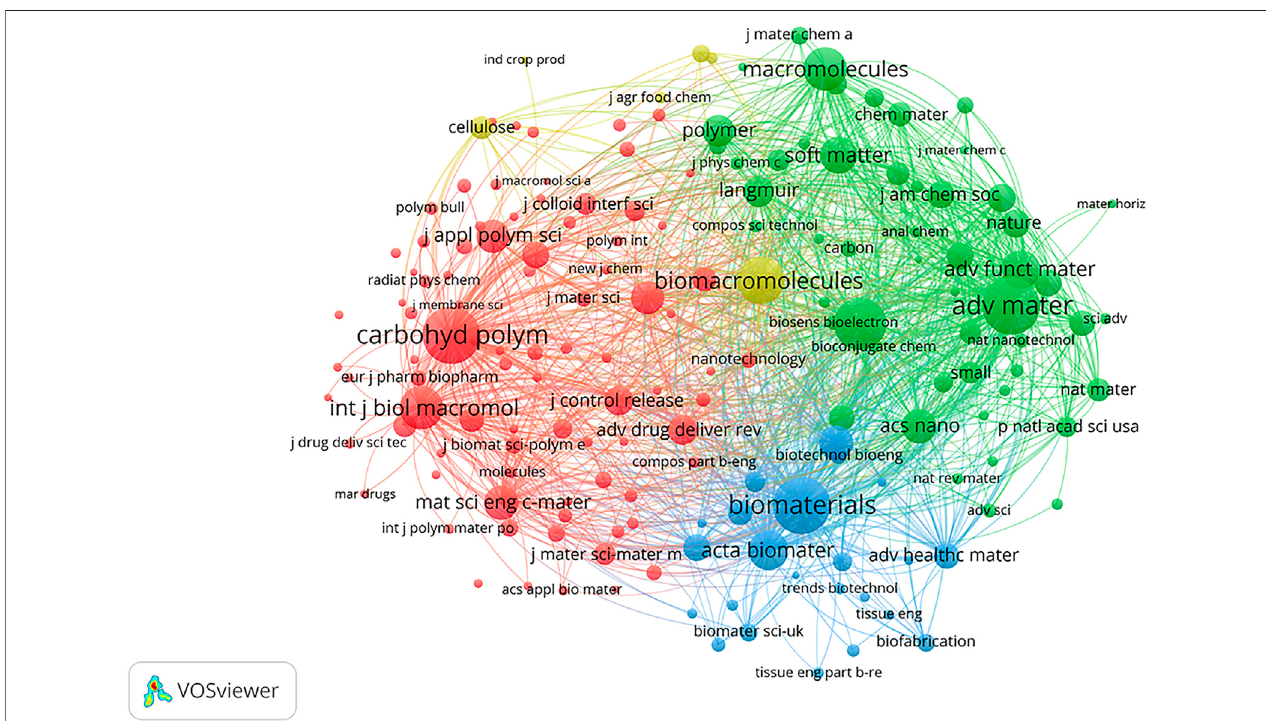
FIGURE 7 | Co-citation network of journal references about nanocomposite hydrogel and related research. Co-citation analysis of journals.